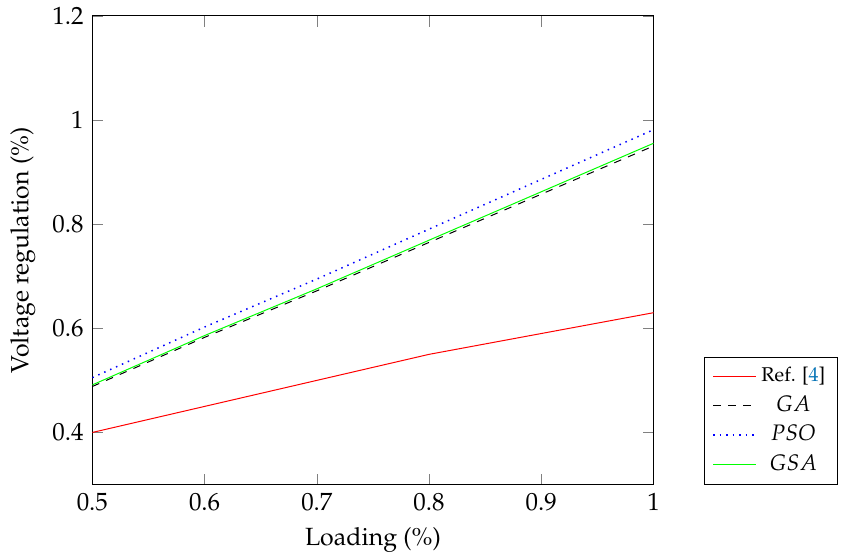
Figure 6. Voltage regulation by varying the load on the 15 kVA single-phase